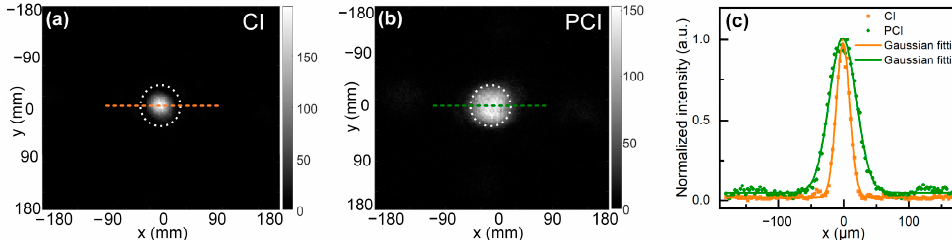
Figure 3. Spectra of CI-QPCM and PCI-QPCM. ( a , b ) The spectra of CI-QPCM and PCI-QPCM in the absence of any samples, which corresponds to the dc term of the object waves when loading a sample. The dash circles in ( a , b ) indicate the areas of the undiffracted components. ( c ) The intensity distributions along the dash lines in ( a , b ). The curves in ( c ) are the gaussian fits.